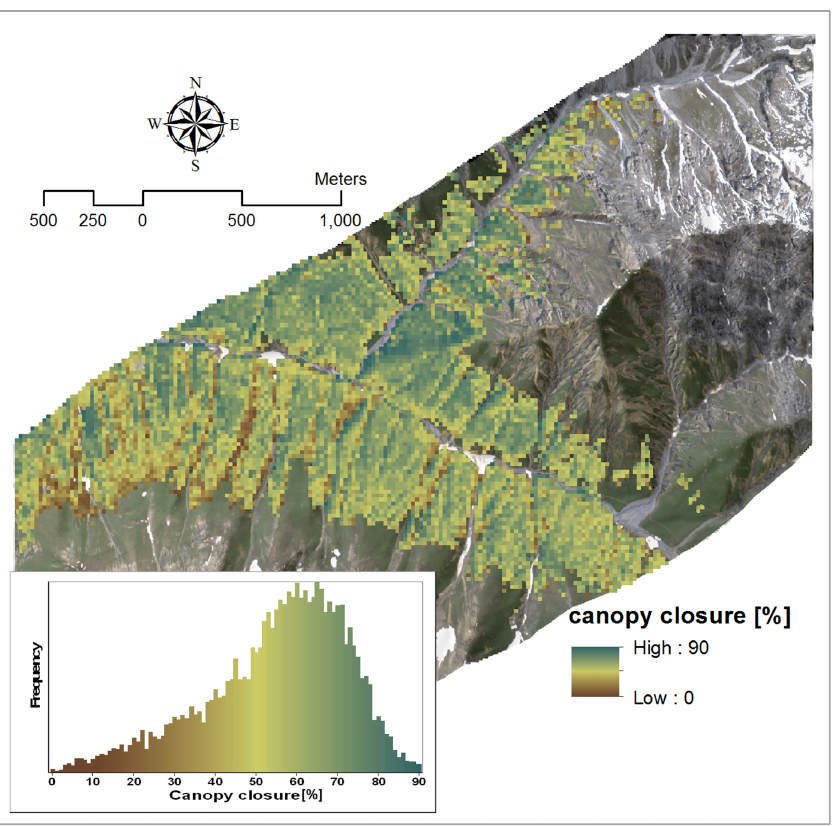
Figure 2. APEX derived forest canopy closure; an APEX true color composite is used as background.